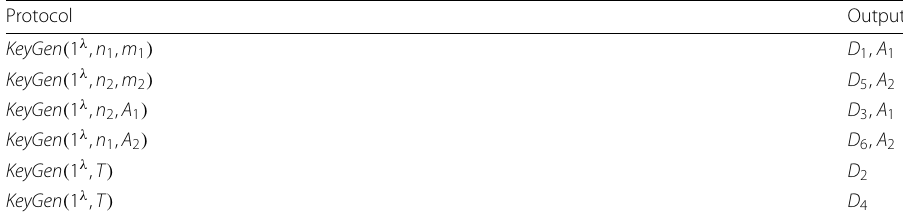
Table 1 Key generation protocol run by U per batch